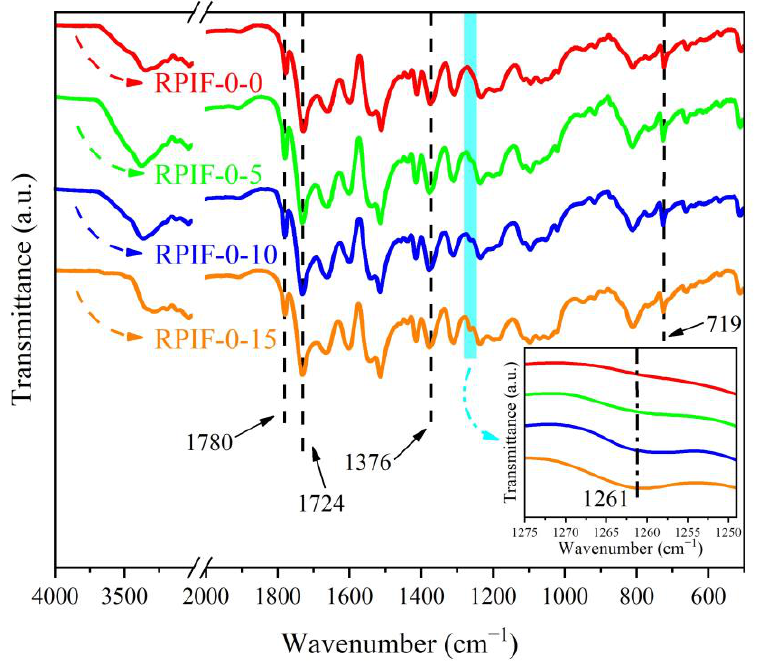
Figure 4. FT-IR curves of RPIF-0-P series.